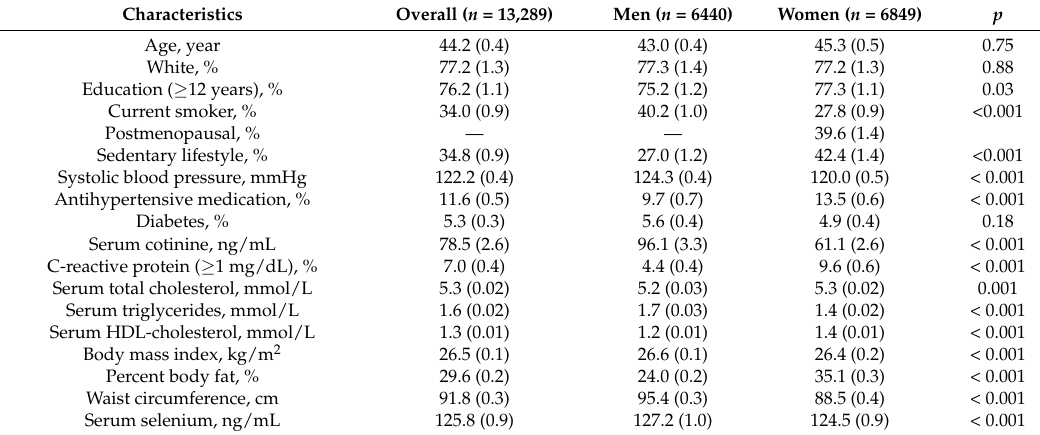
Table 1. Baseline characteristics of the study population by gender †.